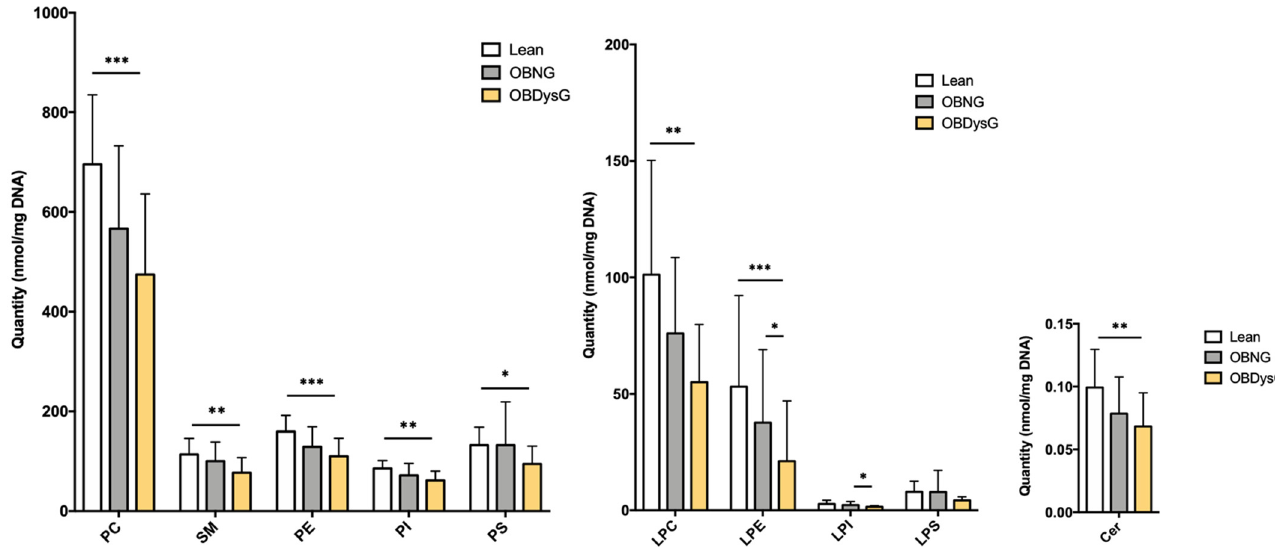
Figure 3. Absolute abundance (nmol/mg DNA) of each lipid class in PBMCs from lean, OBNG and OBDysG patients. Data are mean ± SD. * p ≤ 0.05; ** p ≤ 0.01; *** p ≤ 0.001. Kruskal–Wallis followed by Dunn post hoc test was performed on data. Lean ( n = 14), OBNG ( n = 18) and OBDysG ( n = 25).